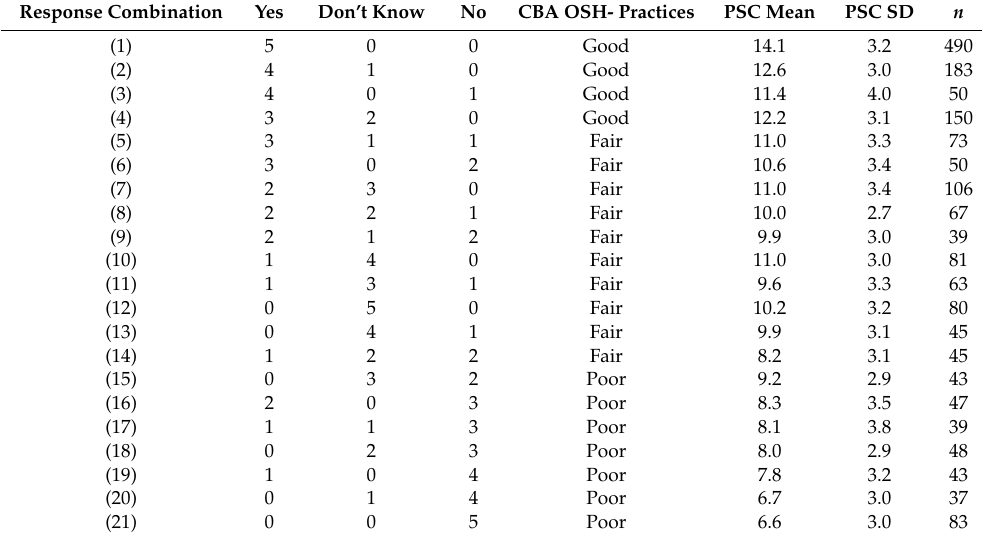
Table A4. Classification of OSH practices according to the criterion based approach (CBA) into good practices, fair practices, and poor practices based on the number of responses found in the response categories yes, don’t know, and no out of 5 OSH items linked to the Swedish regulations: for each response combination, the PSC mean and standard deviation as well as number of respondents is presented, based on a random sample of non-managerial employees Swedish working population ( n = 1862). Response